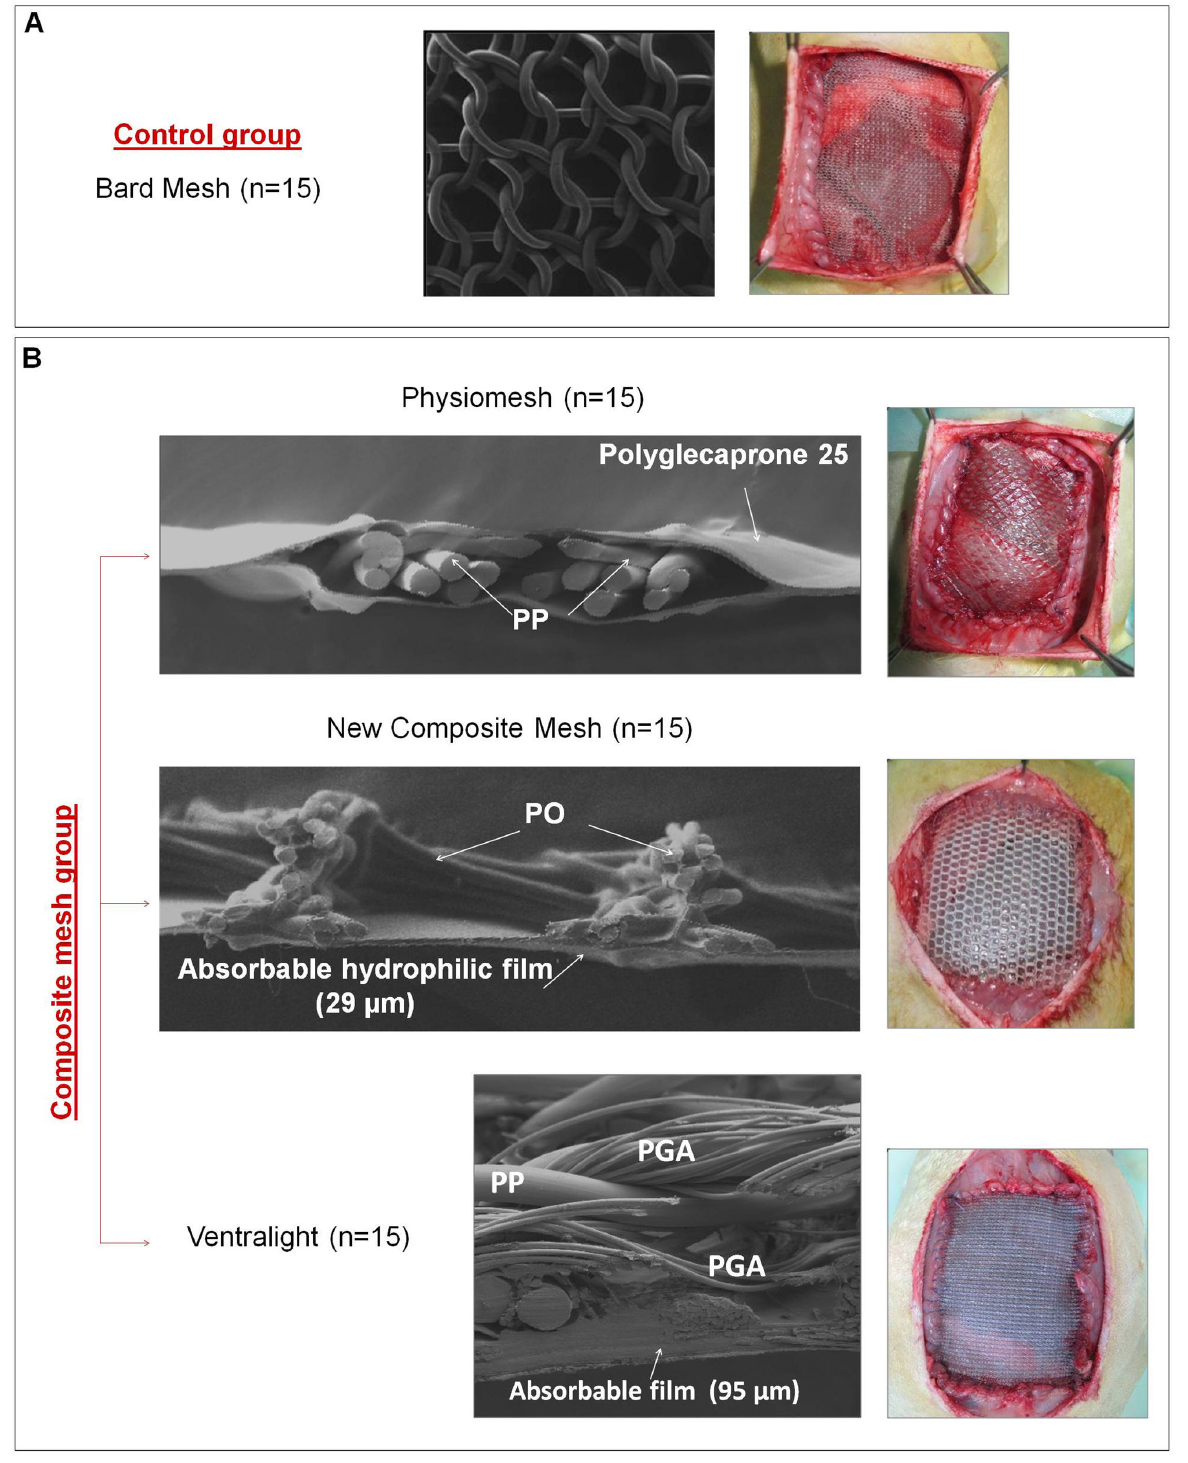
Figure 1. Characterization of the prosthetic materials. Scanning electron microscopy (SEM) images and macroscopic appearance of the meshes after their implant in the experimental animal. A) Control group: Bard mesh TM (20x). B) Composites: Physiomesh TM lateral view (20x); new composite mesh (20x) and Ventralight TM lateral view (100x). Polypropylene (PP), Polyester (PO), polyglycolic acid (PGA). doi: 10.1371/journal.pone.0080647.g001 PLOS ONE |